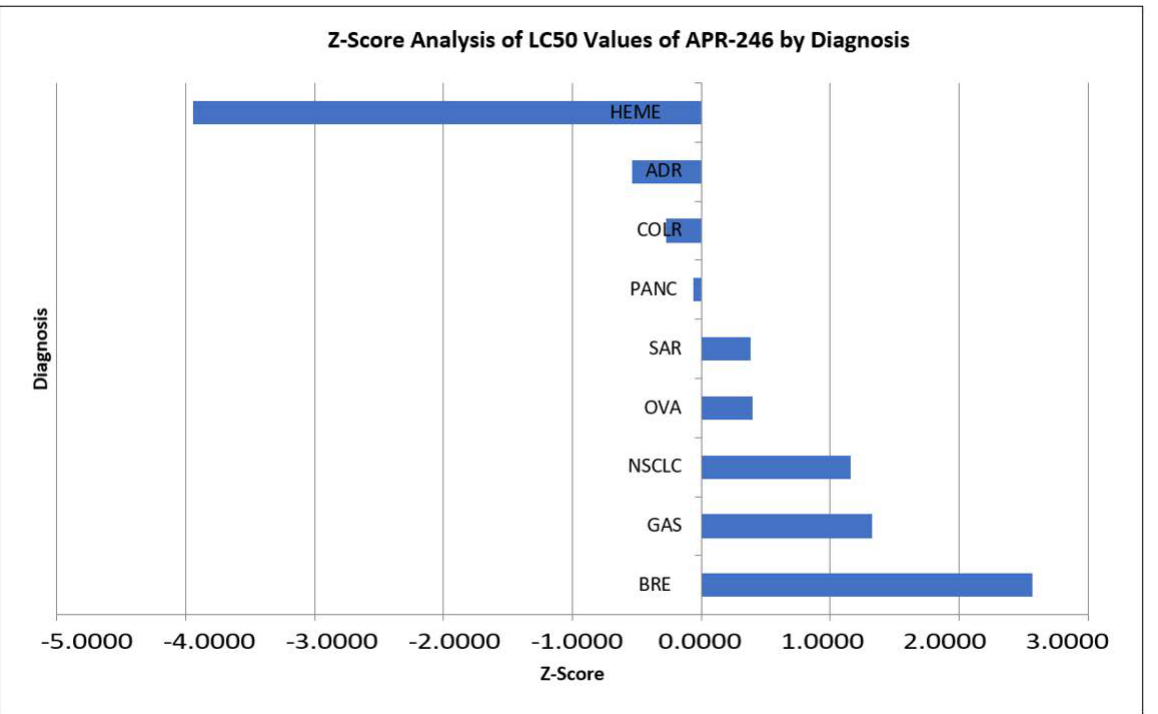
Figure 1. Lethal concentration (LC50) values were compared using Z-scores calculated by the formula Z = X − U/S, where X = Mean value, U = Sample value and S = Standard deviation. Results falling to the left of mean are more sensitive. Results falling to the right of mean are more resistant: Heme = Hematologic tumors; Adr = Adrenocortical; Colr = Colorectal; Panc = Pancreatic; Sar = Sarcoma; Ova = Ovarian; NSCLC = Non-small cell lung cancer; Gas = Gastric; Bre =